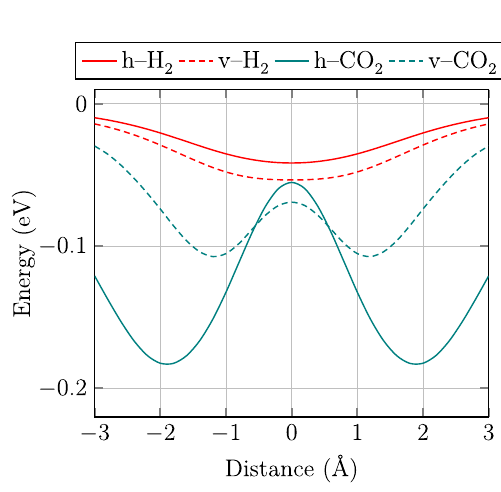
Figure 3. Minimum energy pathways for H 2 and CO 2 gases passing horizontally (h) and vertically (v) through 3Å from the center of the GDY-H membrane in the distance ±